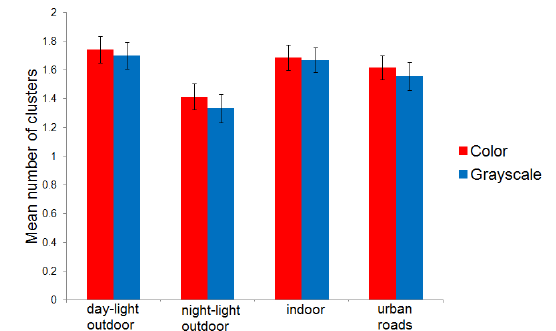
Figure 6 . Mean number of clusters according to stimulus category. Error bars represent the standard error (standard deviation divided by the root square of the number of items).